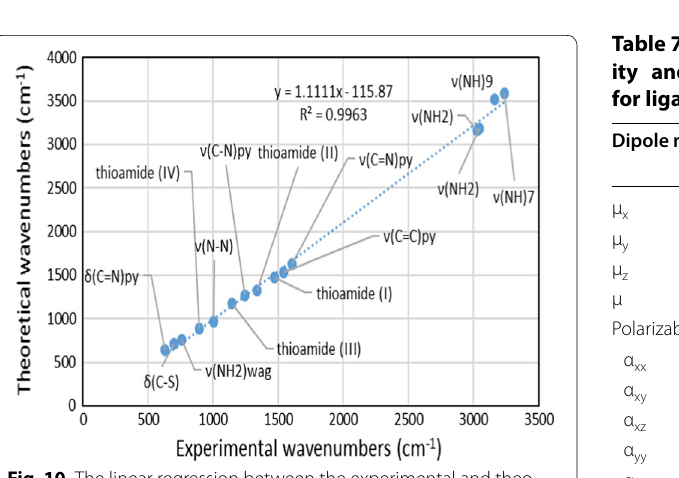
Fig. 10 The linear regression between the experimental and theo‑ retical frequencies of N ‑(pyridin‑2‑yl)hydrazinecarbothioamide